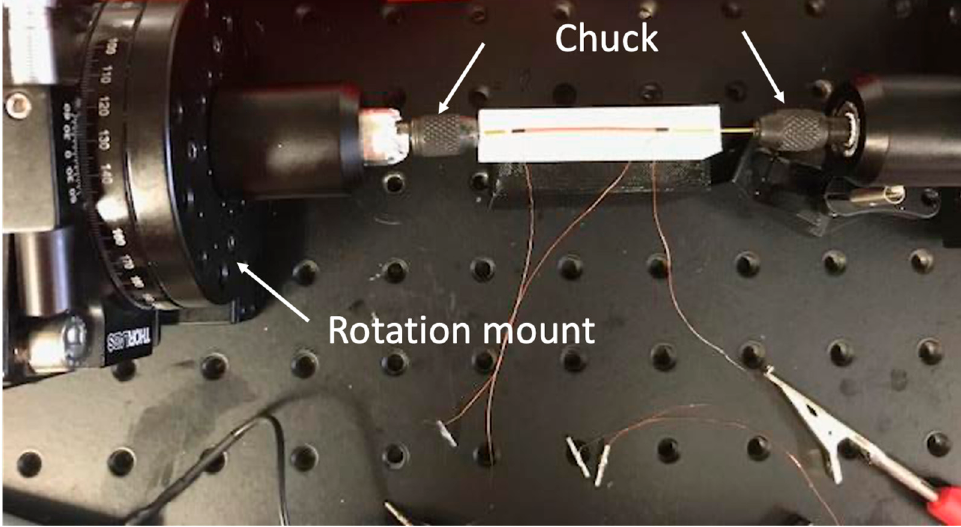
Figure 5. Holding amorphous wire from both sides. (Method number two).